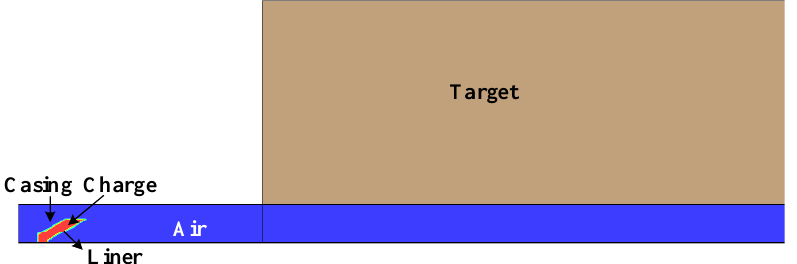
Figure 4. Model schematic diagram.